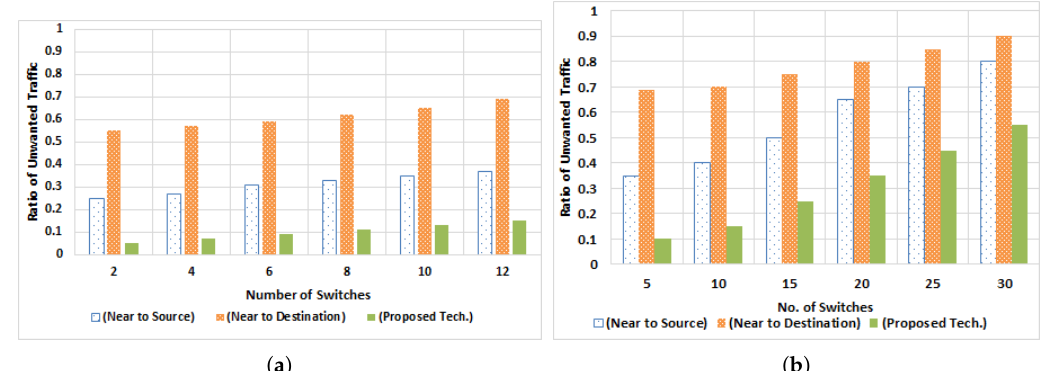
Figure 20. Simulation results of proposed and existing approaches for Traffic Optimization. ( a ) Traffic Optimization when Number of switches is varying, and the number of policies is constant; ( b ) Traffic Optimization when Number of switches is varying and number of policies is